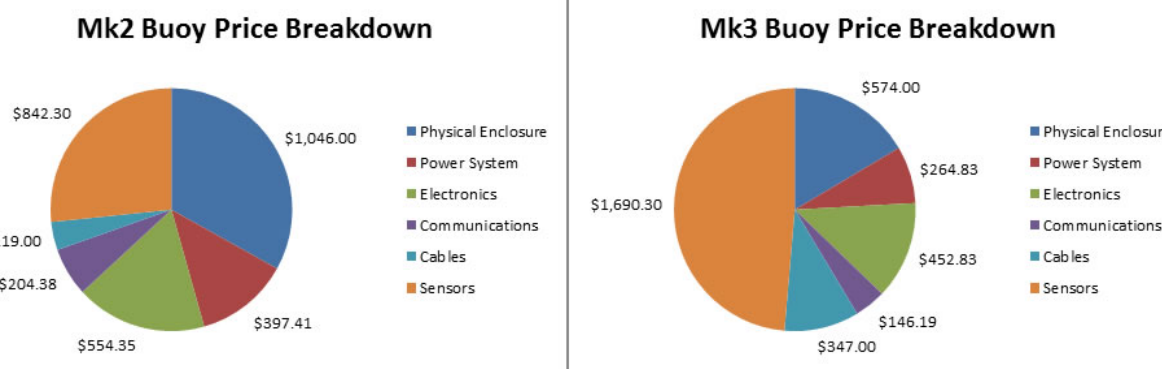
Figure 26. Cost breakdown and comparison for the SEMAT Mk2 and Mk3